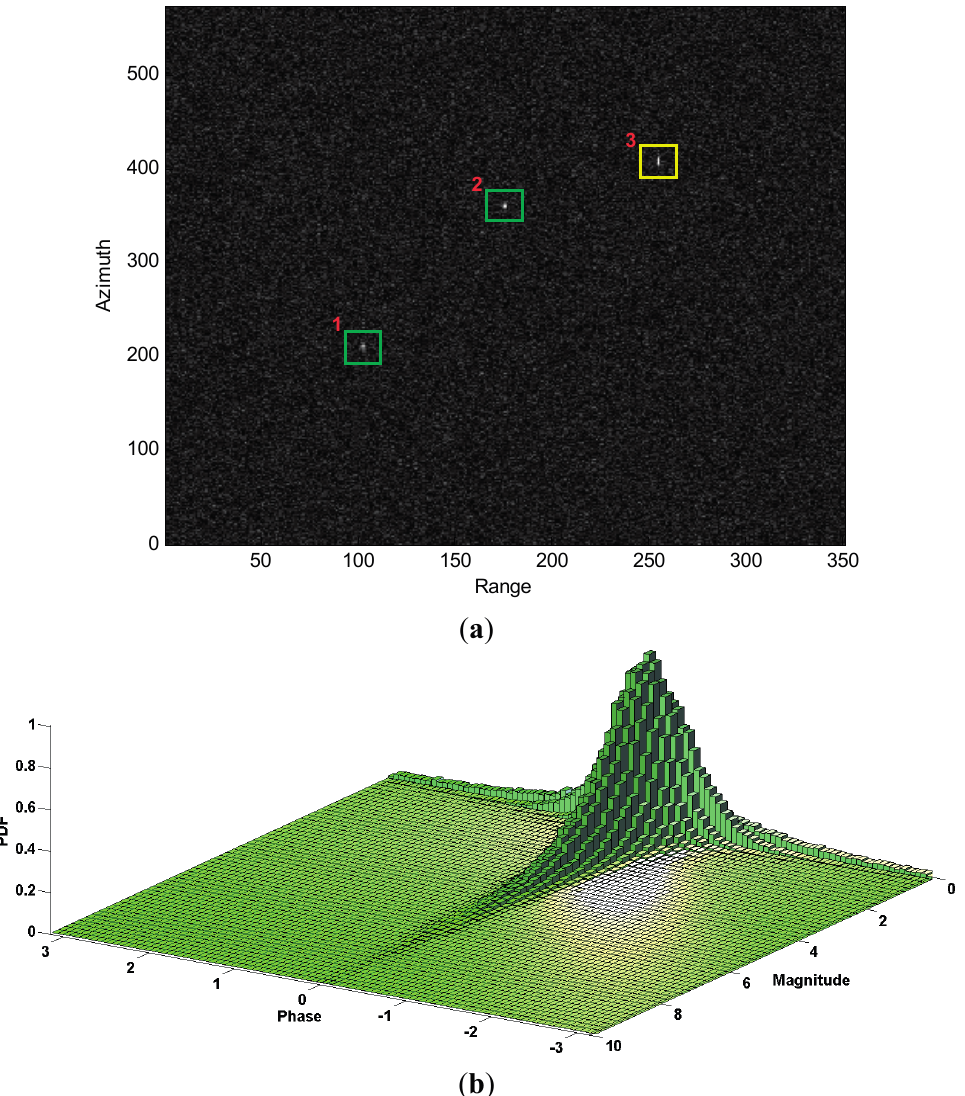
Figure 1. A typical SAR scene: ( a ) Simulated fore-channel SAR magnitude image; ( b ) The corresponding 2-D